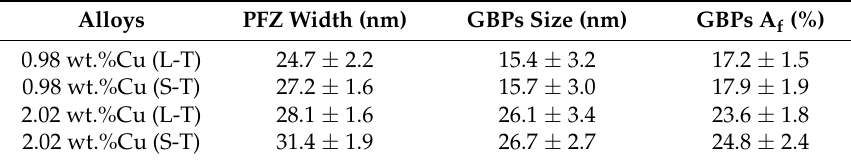
Table 3. Summary of data showing grain boundary microstructures of the alloys.